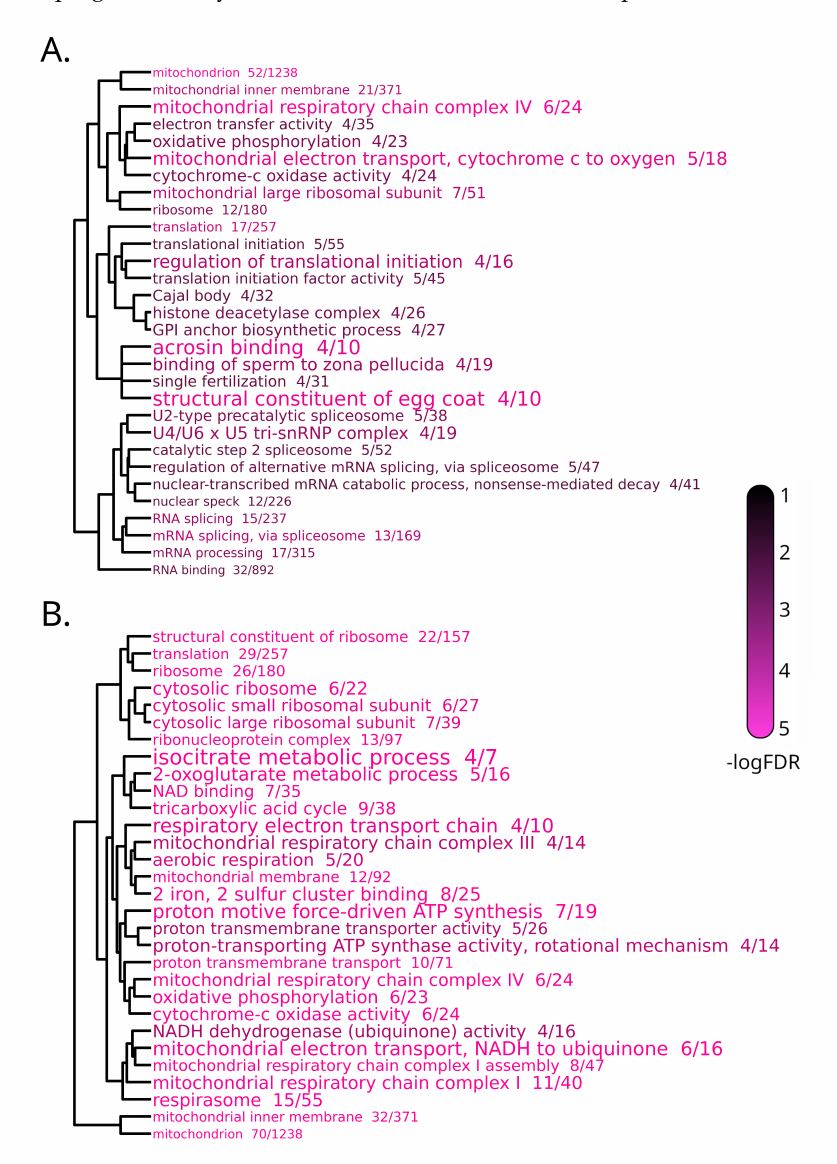
Figure 7. Dendrogram representation of complete linkage of overlapping DEGs associated with the top 30 most significantly enriched GO terms in clusters 2 ( A ) and 3 ( B ) of the transcriptomic response to stabling stress in brain. The size of the GO terms codes for the observed/expected value, the color scale for statistical